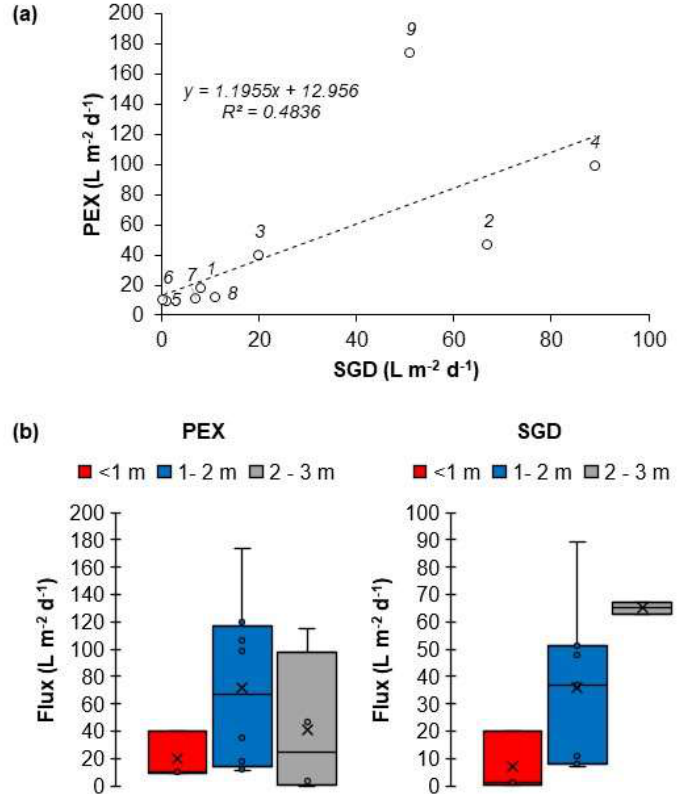
Figure 7. Comparison between mean PEX and SGD from the literature analysis ( a ). Generalized tidal range classification for all sites versus PEX and SGD ( b ). Italicized numbers in ( a ) correspond to the following sites: 1 = Great Sippewissett, MA; 2 = Pamet River Estuary, MA; 3 = Sage Lot Pond, MA; 4 = Jamaica Bay, NY; 5 = Carter Creek, VA; 6 = Eagle Bottom, VA; 7 = Ringfield Marsh, VA; 8 = Elizabeth River Estuary, VA; 9 = North Inlet, SC.